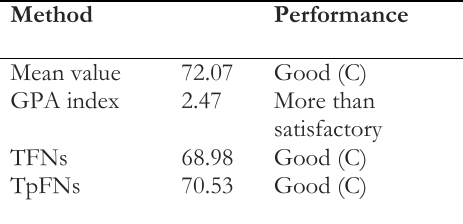
Table 3. The outcomes of Example